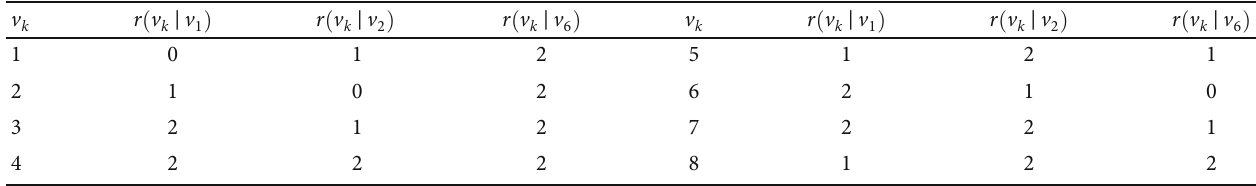
g : = f v , v , v 1 2 6 a